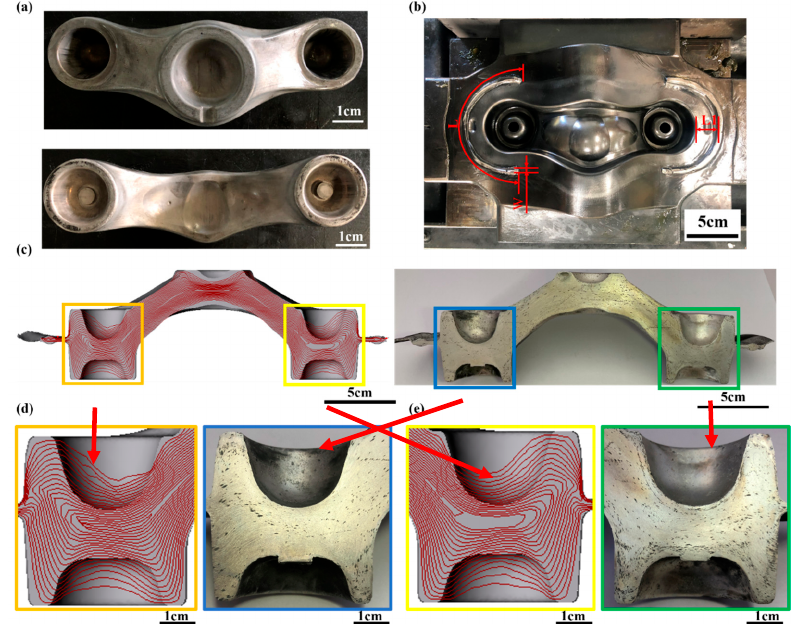
Figure 12. View of crown forgings. ( a ) Top and bottom view of the finishing forging; ( b ) view of actual counter (22 mm) with barrier wall design; ( c ) cross-sectional view of the finishing forging with grain streamlines (left: simulation; right: experiment); ( d ) enlarged view of the left side of the finishing forging with grain streamlines (orange squares: simulation; blue squares: experiment); ( e ) enlarged view of the right side of the finished forging with grain streamlines (yellow square: simulation; green square: experiment).